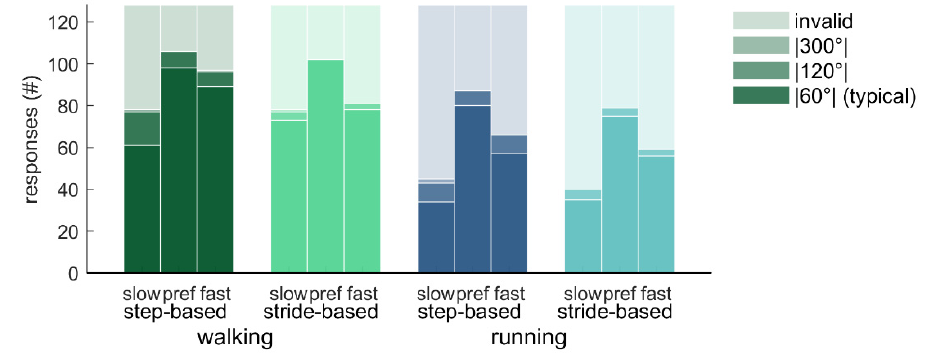
Figure 5. Distribution of response types over the di ff erent conditions. The total number of perturbations was 128 (16 participants times eight perturbations per condition).